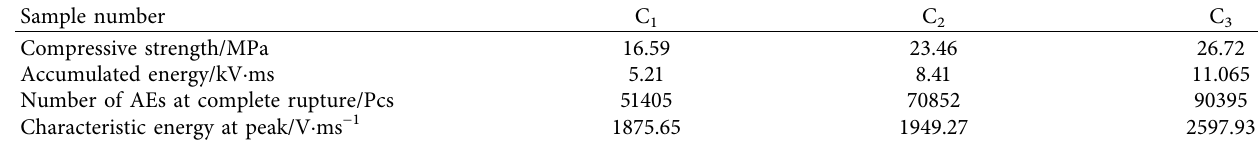
Table 2: Compressive strength and acoustic emission energy of different